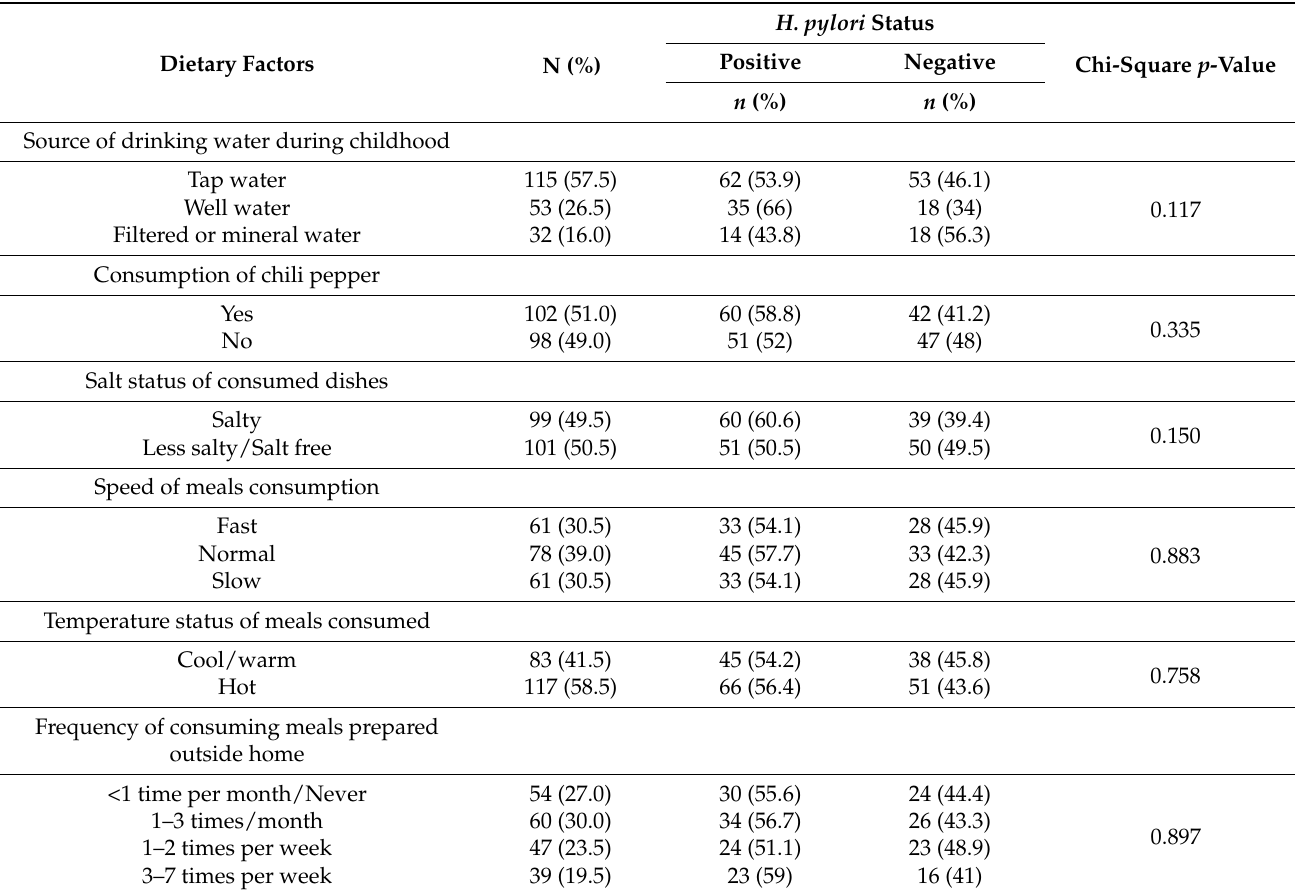
Table 5. Dietary habits of the study participants and their association with H. pylori status.